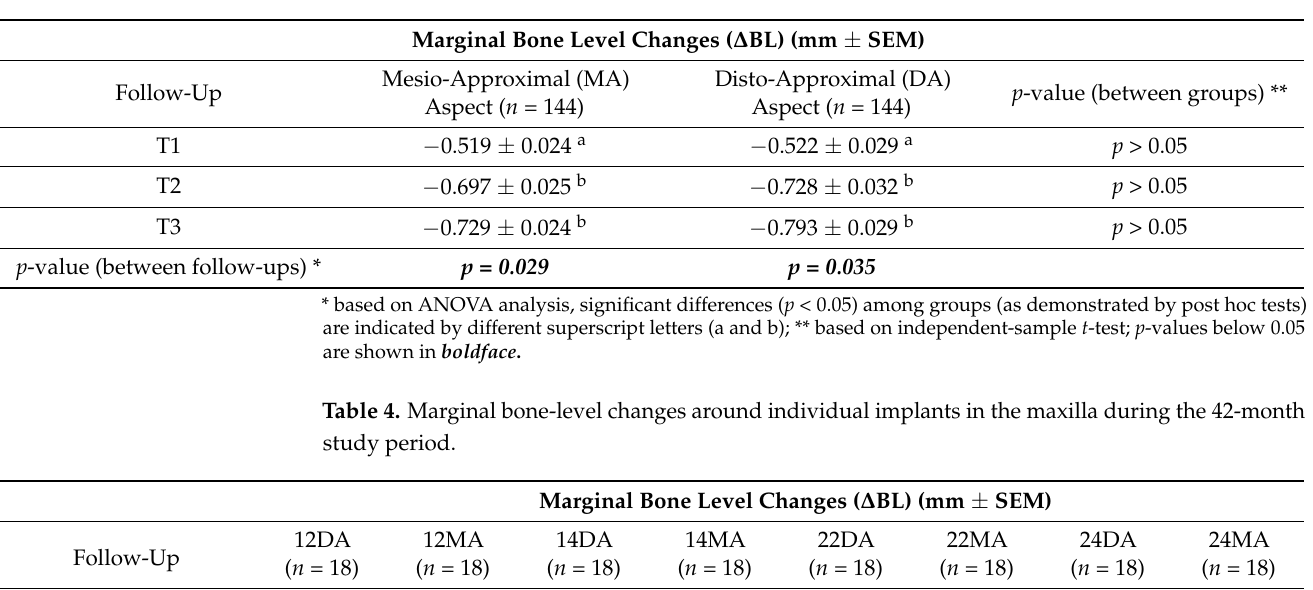
Table 3. Marginal bone-level changes on the mesio- (MA) and disto-approximal (DA) aspects of the implants during the 42-month study period.